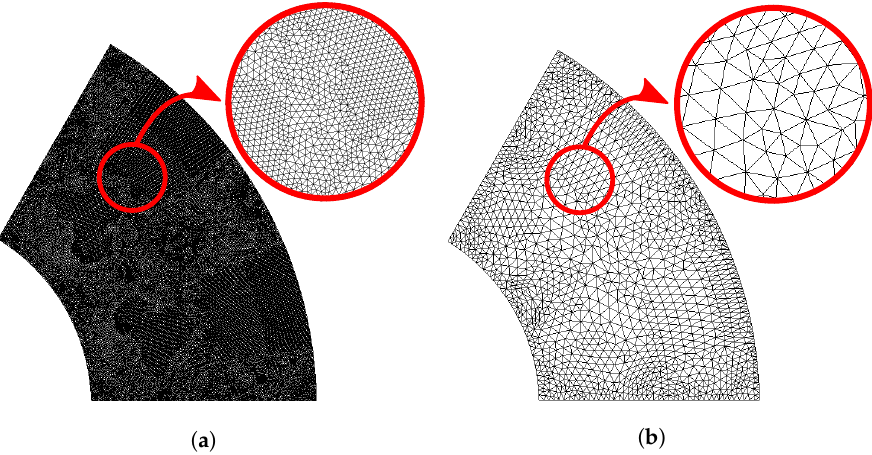
Figure 3. Maximum and minimum mesh densities used for optimization; maximum mesh length of: ( a ) 0.25 mm and ( b ) 2